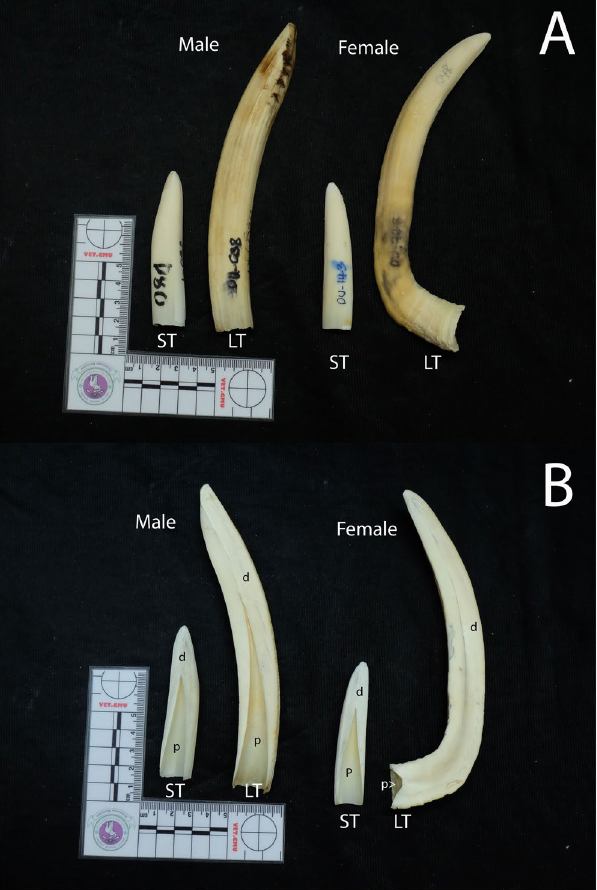
Figure 5. Comparative morphology of small tusks (ST) and large tusks (LT) in male and female dugongs, left lateral view ( A ) and median plane section ( B ). It was difficult to use small tusks for sex identification, even when observing median plane sections; dental pulp (p) was similar between both sexes. In large permanent tusks there was a clear difference between sexes; dental pulp in males was triangle-shaped (similar to small tusks), but female tusks were filled with dentine, with only a small amount of dental